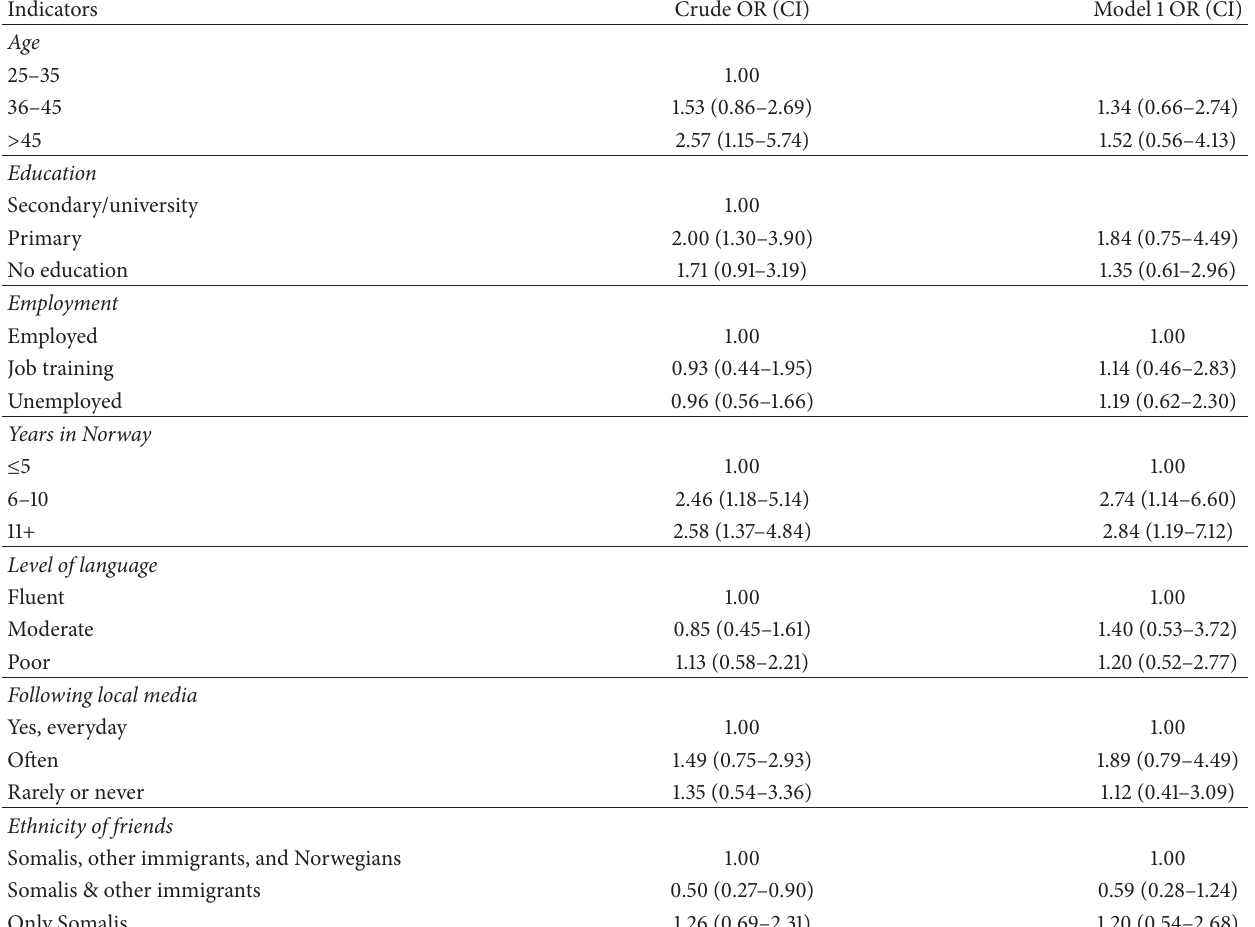
Table 4: Association between sociodemographic variables and diabetes